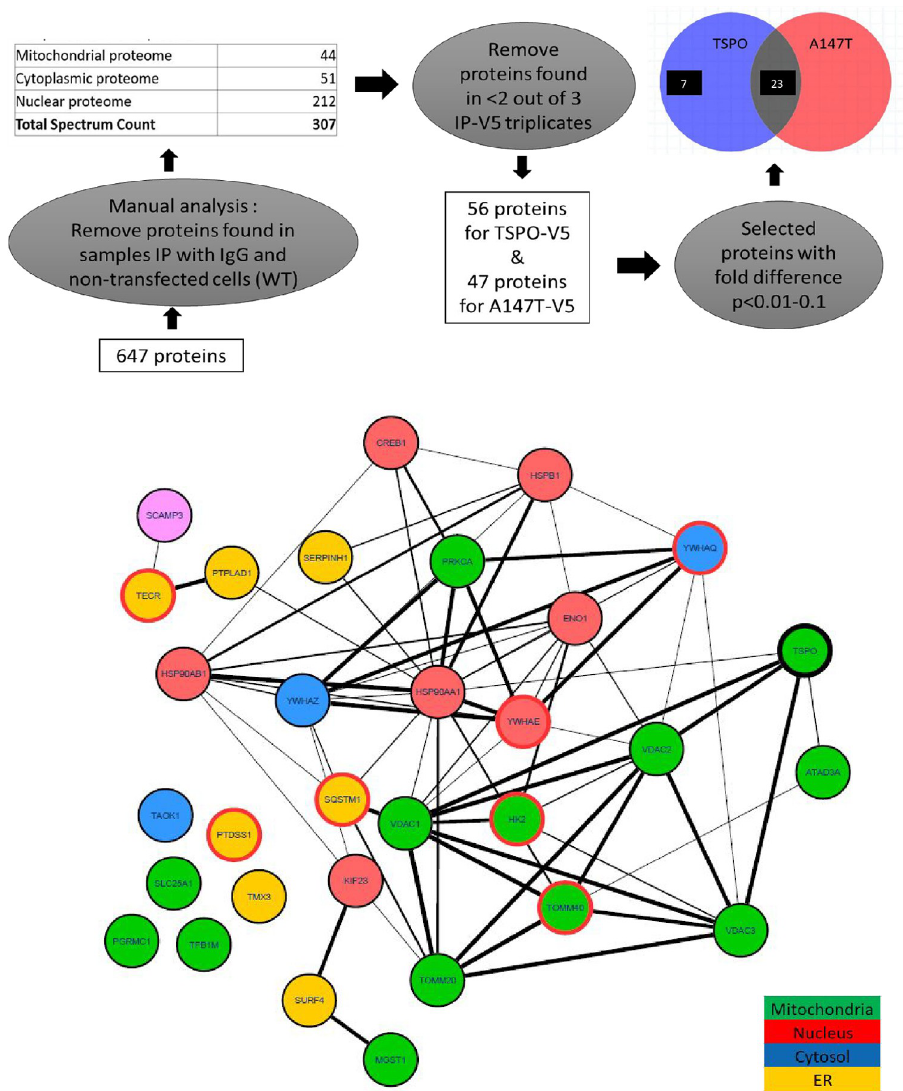
Fig 2. Identification of binding partners of hTSPO WT and hTSPO A147T by label free semiquantitative proteome analysis. A) Diagram of the immunoprecipitation-mass spectrometry approach to identify the TSPO WT and TSPO A147T interactomes. We identified 56 proteins for V5-tagged human TSPO WT and 47 proteins for human TSPO A147T , of which two thirds comprised of mitochondrial proteins and the remainder were cytoplasmic and nuclear proteins. Of these, 23 selected candidates interacted with both TSPO WT and TSPO A147T and 7 candidates interacted only with TSPO WT , after further selection criteria with protein fold difference of p < 0.01–0.1 B) A functional protein association network generated using STRING (v10.5) and Cytoscape (v6.3.0) bioinformatics software. Network edges represent protein-protein associations and represent confidence, with the strength of the association represented by line thickness. The circles (nodes) depict specific proteins, and the color represents sub-cellular localization of each protein, as shown in the legend. The 7 protein candidates which interact solely with TSPO WT are indicated on nodes with red outlines. Nodes with no network edges represent proteins that have never previously been reported as TSPO interaction partners.